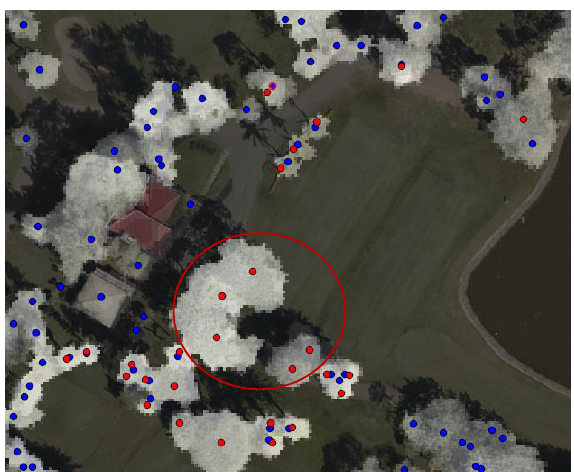
Figure 6. Extraction result by the MMAC method using the pit-free CHM (a ten cm circle as a